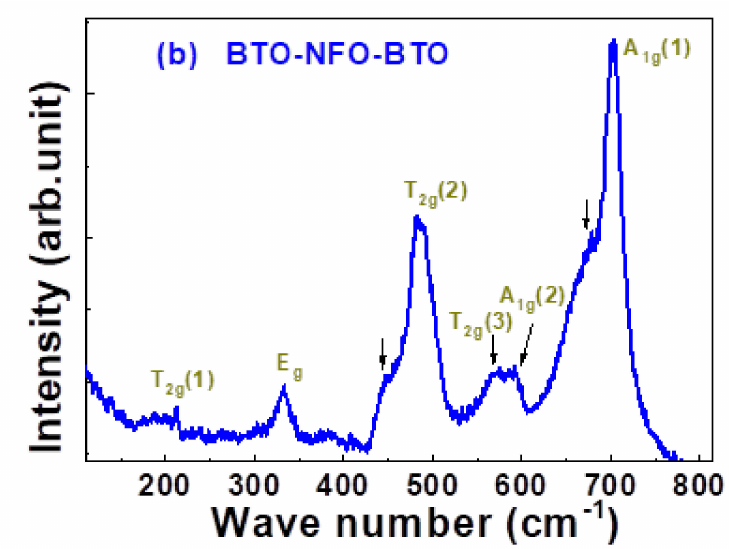
Figure 2. Raman Spectrum of the ( a ) BTO and ( b ) (BTO/NFO/BTO) tri-layered thin film at room temperature.